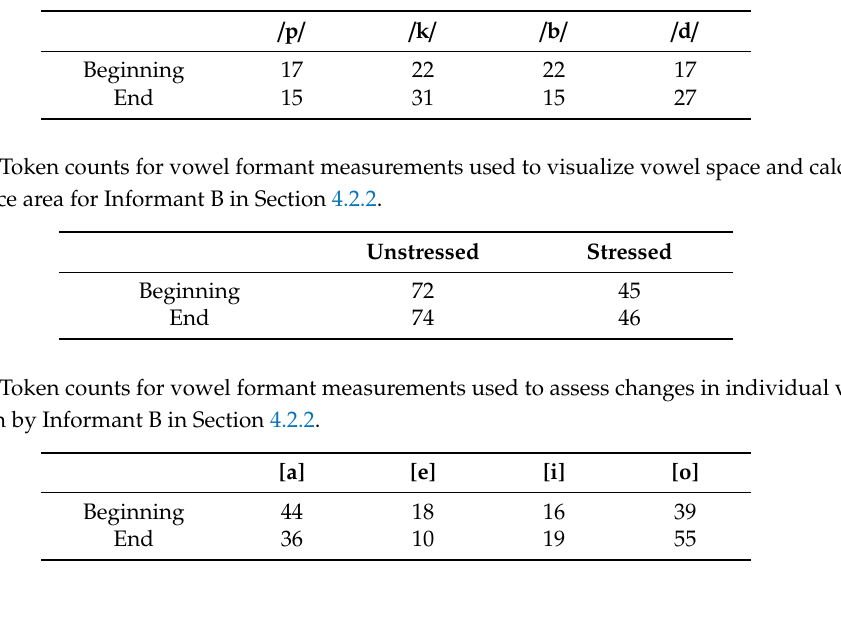
Table A4. Token counts for consonant measurements used to assess changes in production of voiceless and voiced consonants by Informant B in Sections 4.1.1 and 4.1.2.